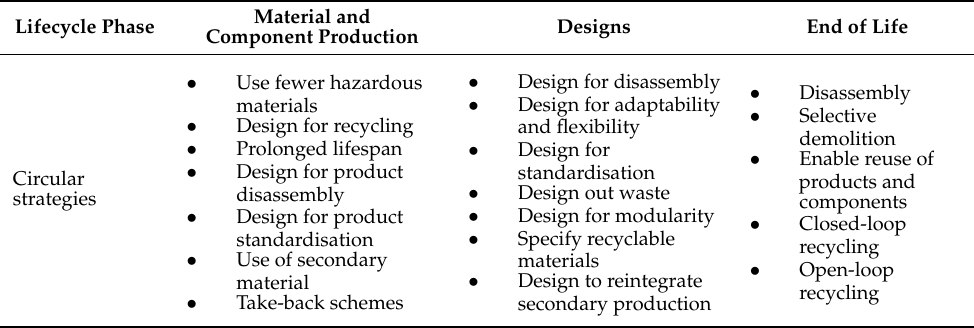
Table 2. Overview of the circular strategies developed and discussed in the literature for the three selected lifecycle